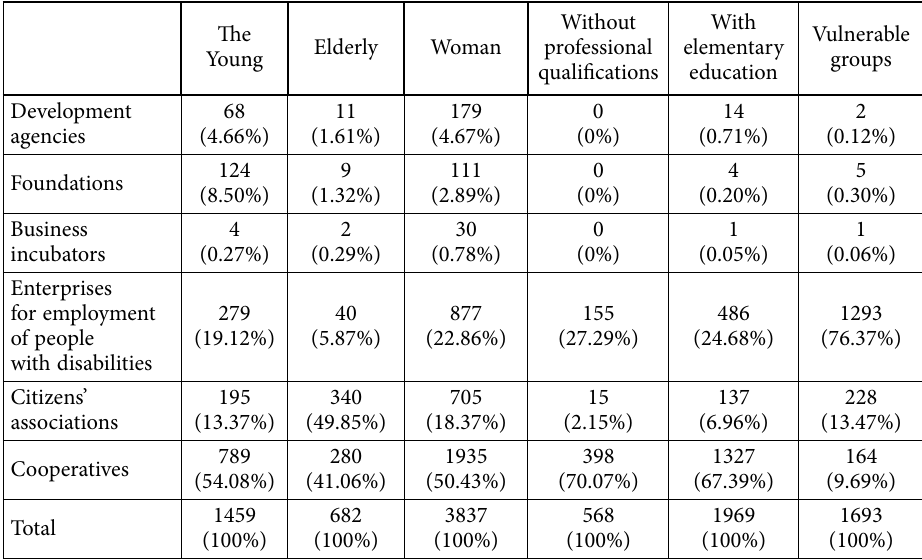
Table 1. Cross-tabulation between types of social enterprises and employed categories (source: Authors’ preview based on SORS 2014) Without The Elderly Woman Young